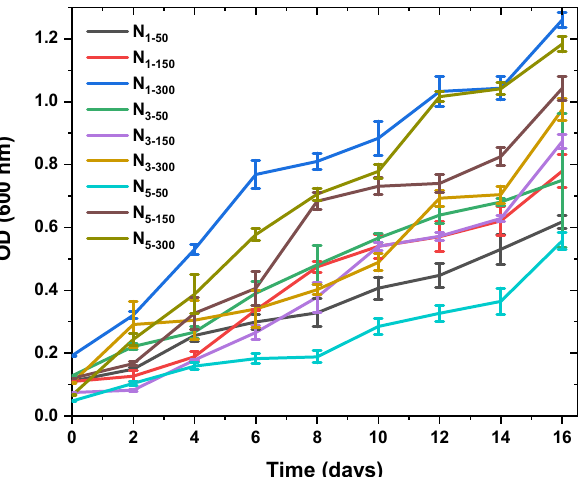
Figure 1. Plot showing the effect of light intensities and aeration rates on the optical density of N. shiloi . Reported results are the average of three replicates (i.e., n = 3), with error bars denoting one standard deviation about the mean.